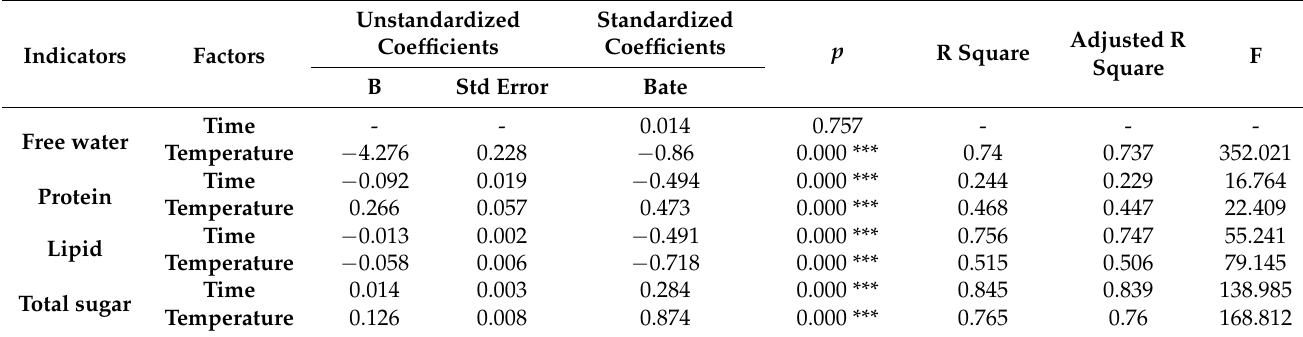
Table 1. Stepwise regression model on the effects of temperature acclimation of free water and nutrient accumulation of queens during